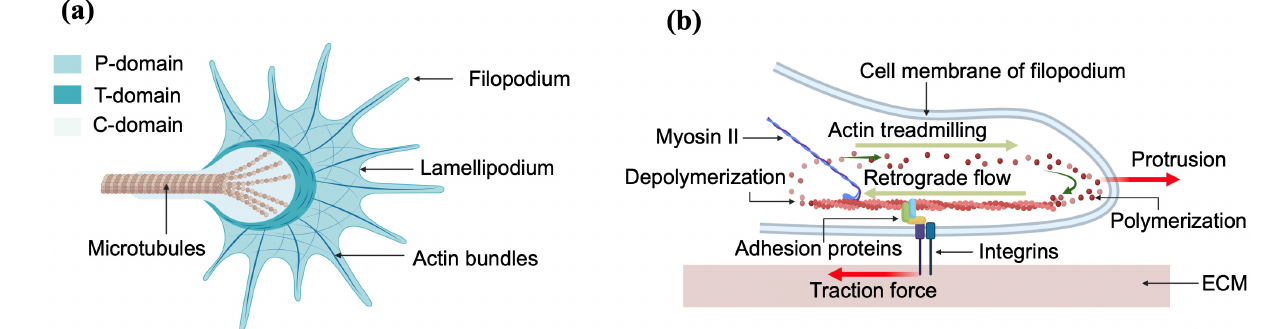
Figure 1. ( a ) Top-view schematic of the growth cone showing the structural components: actin bundles, microtubules, filopodia and lamellipodia; ( b ) side-view schematic of the growth cone showing the generation of traction forces through the interaction between integrins, adhesion proteins and actin bundles.